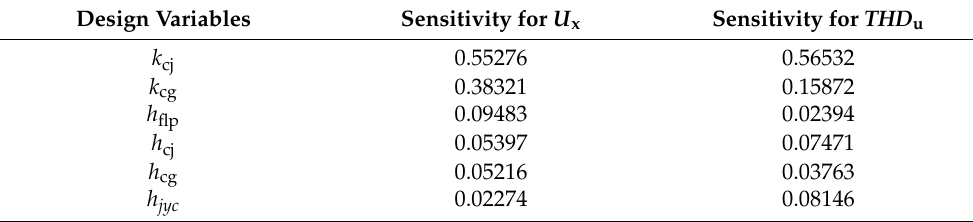
Table 2. Sensitivity of design variables concerning response